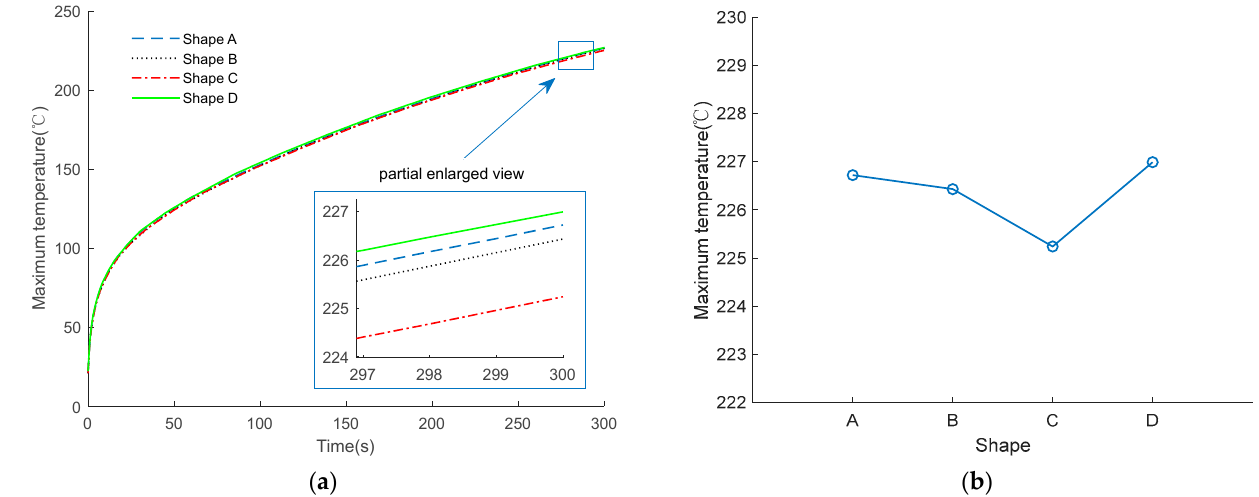
Figure 19. Temperature comparison of four shapes at 1 A constant current excitation. ( a ) Temperature change curve; ( b ) maximum temperature at 300 s.